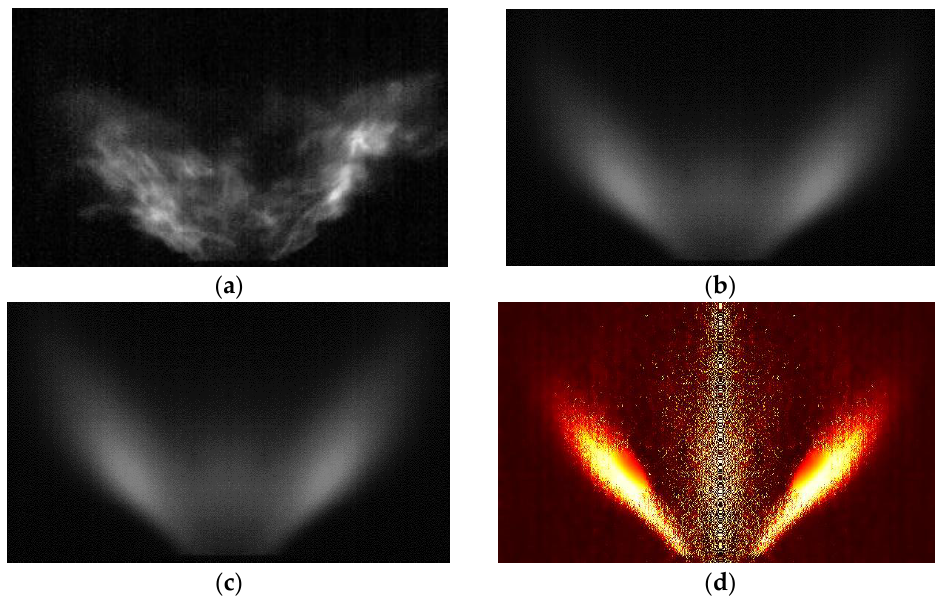
Figure 3. Reconstruction process of flame center section. ( a ) Instantaneous image; ( b ) Time average image; ( c ) Symmetrical average; ( d ) Inverse Abel transform image;